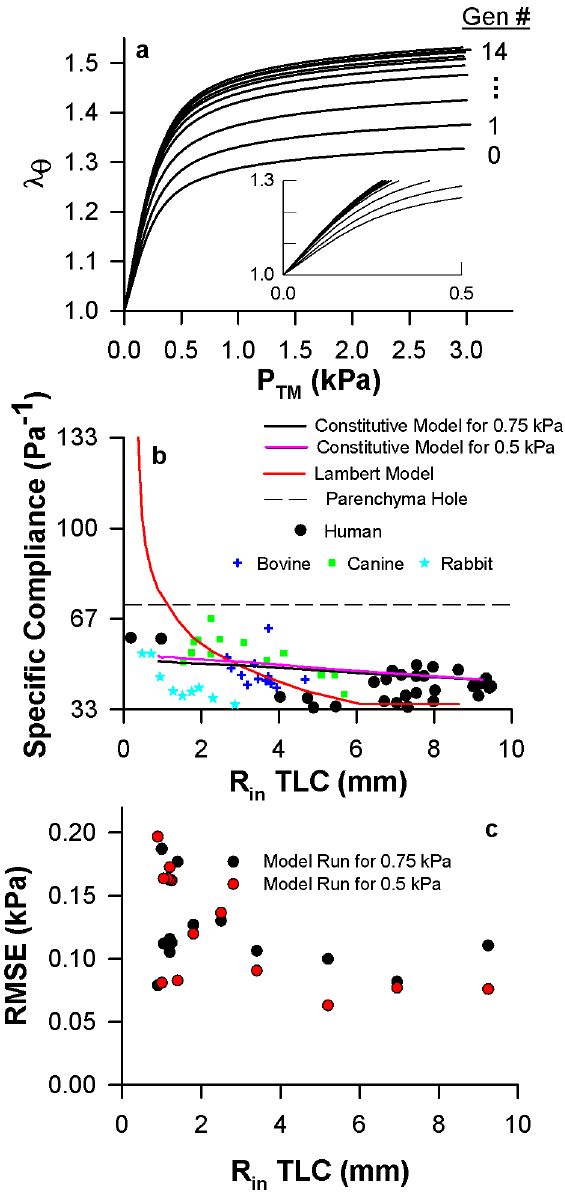
Figure 3. The generation-dependence in airway wall compli- ance is a direct consequence of homeostatic circumferential stresses and incremental elastic moduli throughout the airway tree. a , The relationship between circumferential stretch ratio ( l h ) and transmural pressure (P TM ) for all generations. The inset is an enlargement of the range from 0 to 0.5 kPa P TM . b , The relationship between specific airway compliance from 0 to 3.0 kPa P TM and the luminal radius at TLC for our analysis at both 0.75 operating P TM (black line) and 0.5 kPa operating P TM (magenta line) and reanalysis and plotting a previous model by Lambert et al. [22] (red line). Expansion of a parenchymal hole (dashed line) was calculated assuming that lung volume at 0 kPa P TM is 15% of volume at 3.0 kPa as shown in data [22]. For comparison, our bovine data is shown (blue crosses) along with data visualized from the literature in humans [17–19] (black circles), dogs [20] (green squares), and rabbits [21] (cyan stars). c , The root mean square errors (RMSE) between the model and data assuming optimal P TM of 0.5 kPa or 0.75 kPa as a function of airway radius.